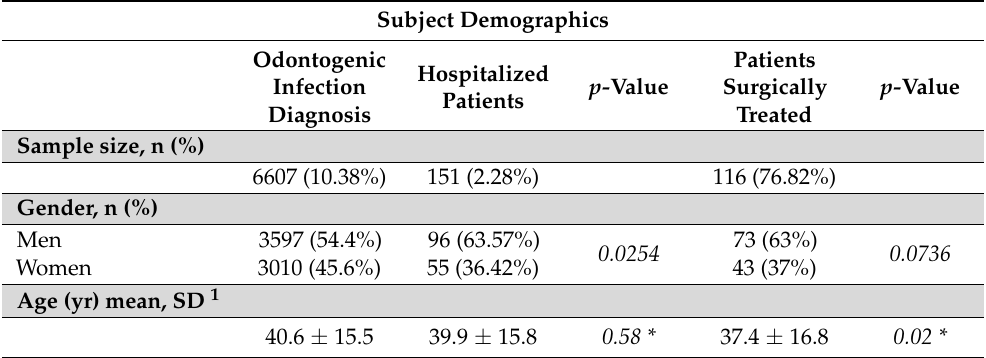
Table 1. Sample characteristics. Descriptive statistics performed by SPSS Software, version 26.0.